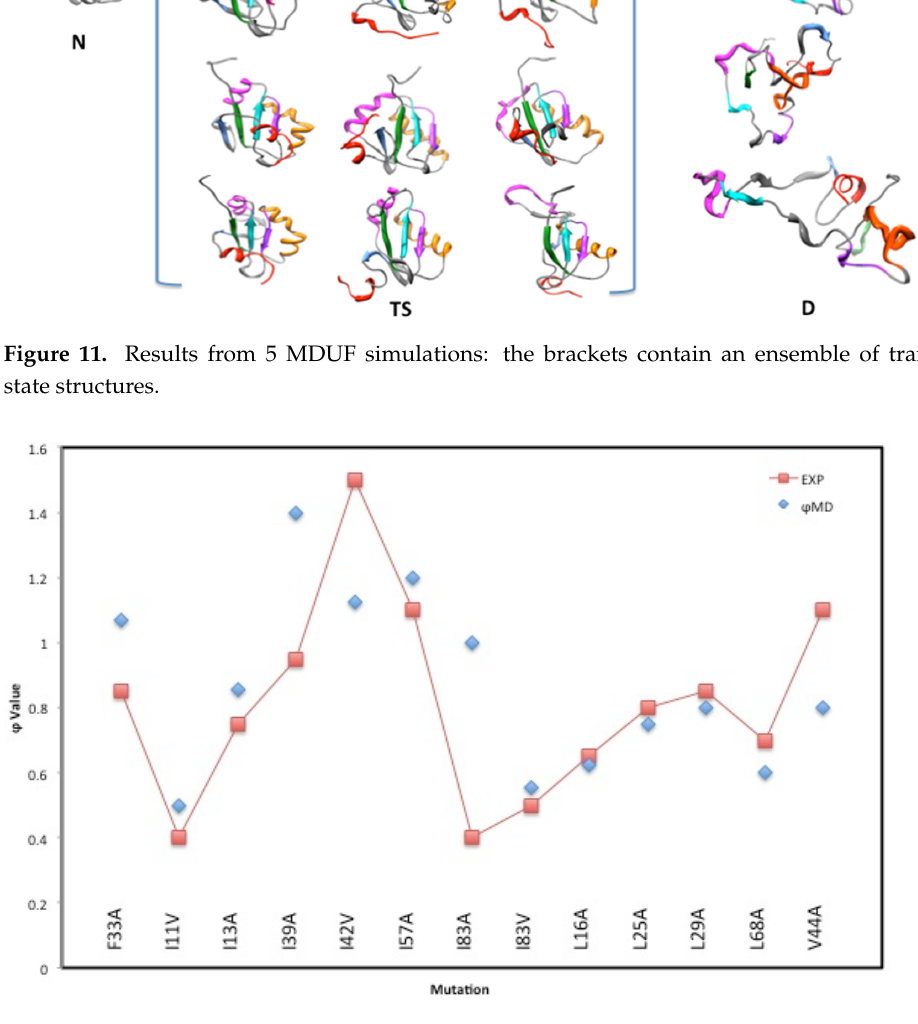
Figure 12. A comparison of experimentally observed [27], and MD calculated φ - values for 13 mu- tants forms of U1A. forms of